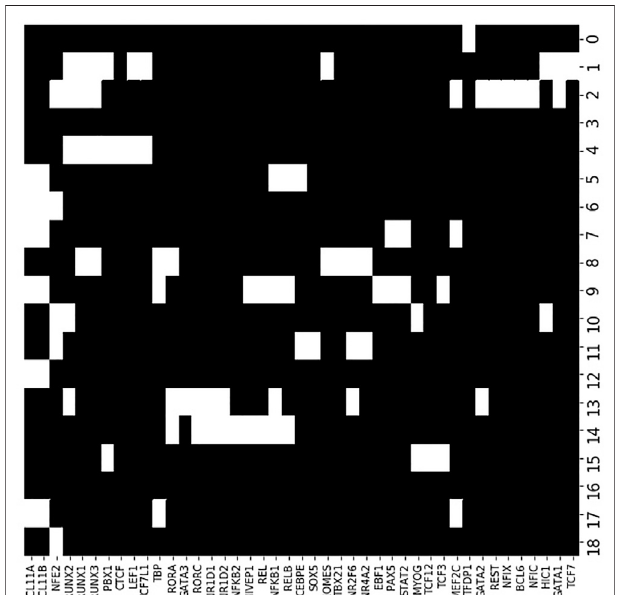
FIGURE 9 | TF motif enrichment associates with particular accessibility co-clusters. We evaluated enrichment of each TF motif (columns) within each accessibility co-cluster (rows). At an FDR of 0.05, we found 43 TF motif, co- cluster pairings that were enriched (white coloring). As a particular example, the BCL11A motif (far left column) was enriched in six accessibility co-clusters, in particular co-cluster 9. Accessibility co-cluster 9 is formed by lociinrowcluster9andBcelltypes.Theco-clusterisvisualizedin Figure8 by the yellow block within row 9.